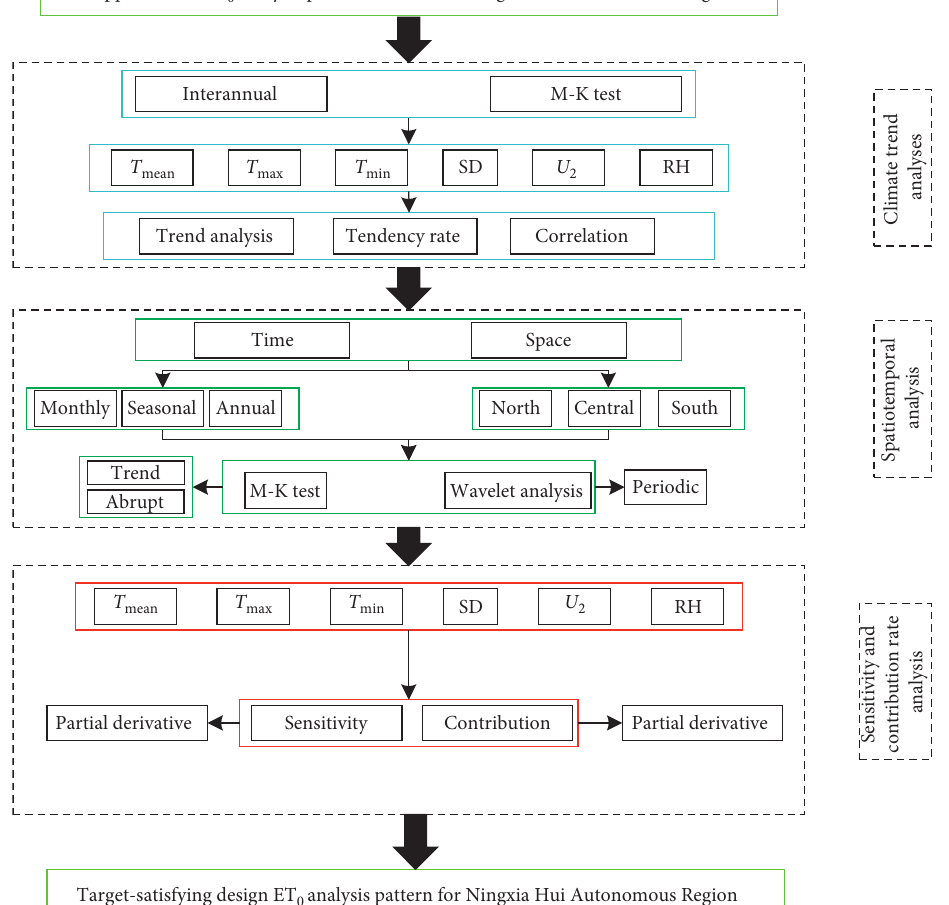
Figure 1: Approach framework, as proposed for ET0